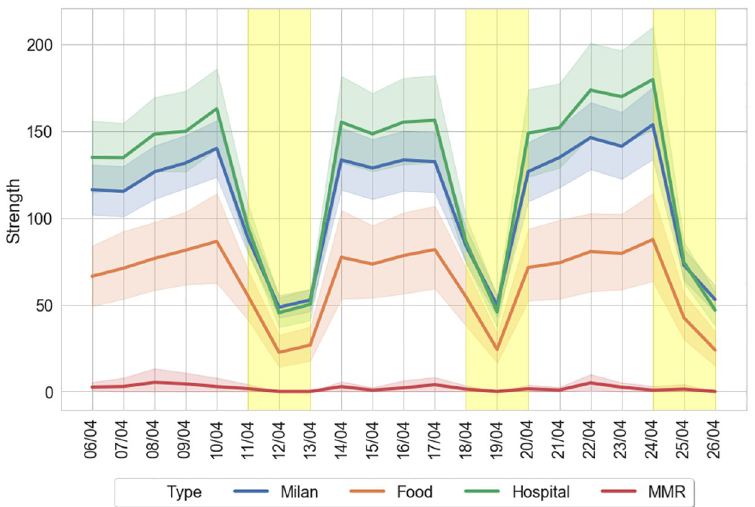
Fig 4. Milan mobility flows. We partition the city of Milan into Bing tiles of size 0.3km by 0.3km. We label each tile as: MMR (in red), Food (in orange) or Hospital (in green) if at least one of the corresponding places of interest is located. Such categorizations are mutually exclusive, meaning that if in the same tile more than one category is present than this tile is not assigned to a specific category. For each category we show the mean value and 95% C.I. with shaded areas; Milan city tiles considered altogether are shown in blue color. Yellow areas indicate weekends and